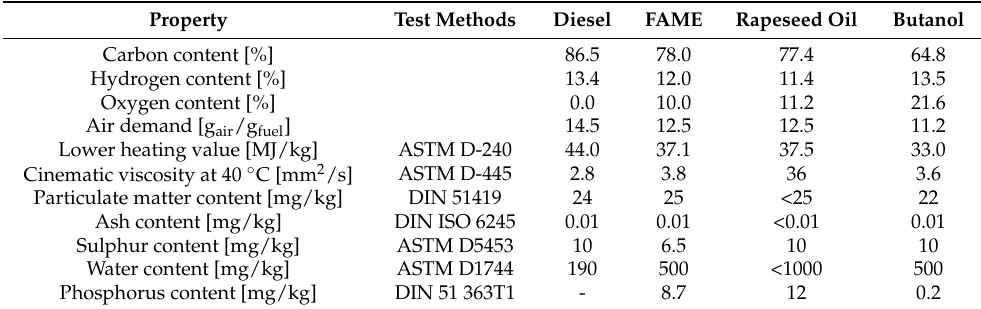
Table 2. Basic properties of fuels used in computer simulation.